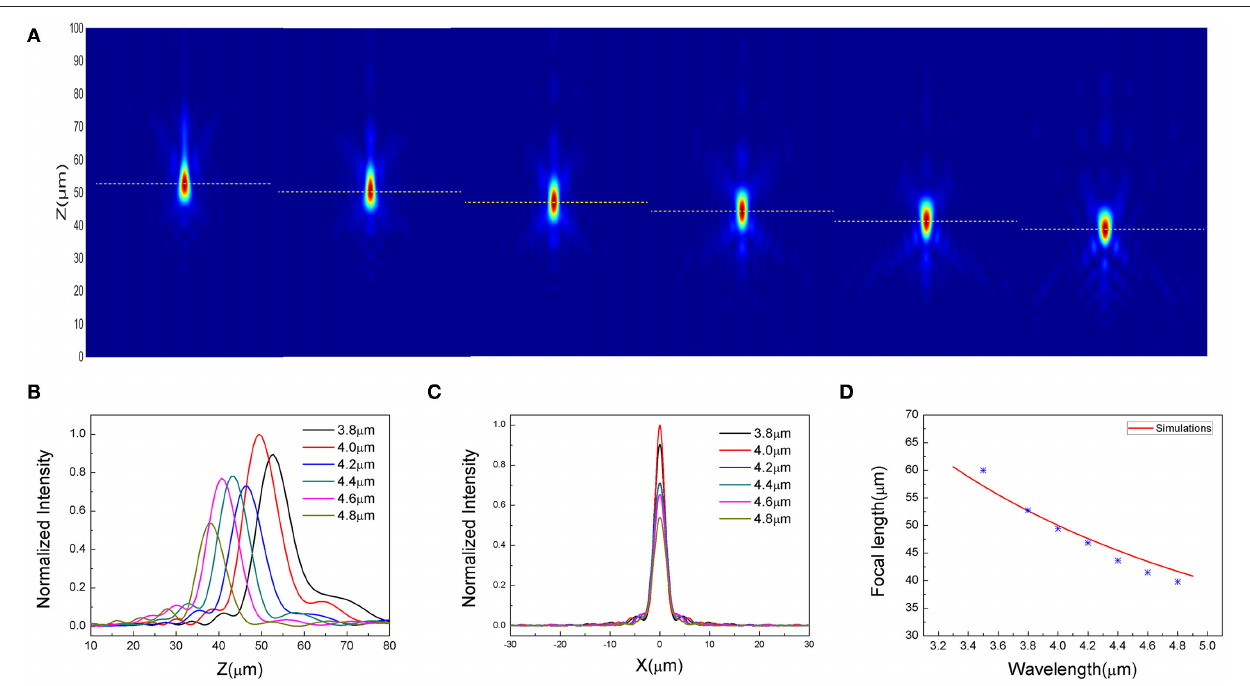
FIGURE 8 | Chromatic aberration analysis under the incidence of x-polarized light ranging from 3.8 to 4.8 µ m. (A) The normalized electric field intensity in the Y–Z plane. (B) and (C) , respectively, represent the normalized electric field distribution of different incident wavelengths on the propagation plane and the horizontal focal plane. (D) The comparison between the focal position of the meta-lens designed in the mid-infrared band (symbol) and the focal point of the traditional diffractive lens (line) is